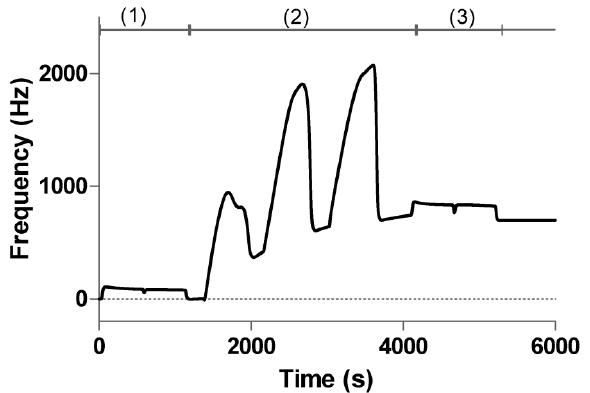
Figure 3. Typical sensorgram of Anti-h myoglobin 7005 immobilization via amine coupling on 3D carboxymethyl dextran surface (2000 kDa). (1) activation by EDC and NHS; (2) coupling of Anti-h myoglobin 7005; (3) deactivation with ethanolamine.